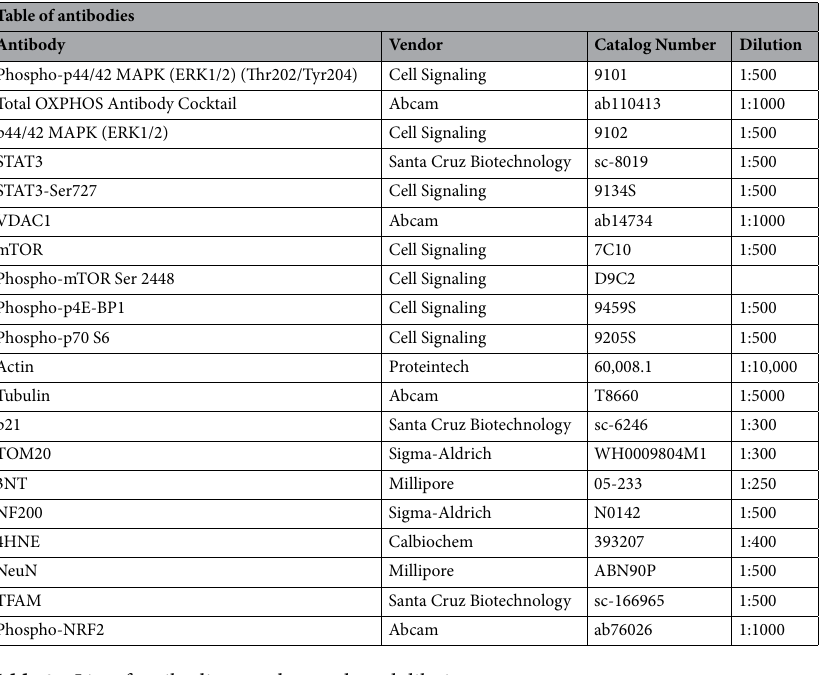
Table 2. List of antibodies, vendors and used dilutions.